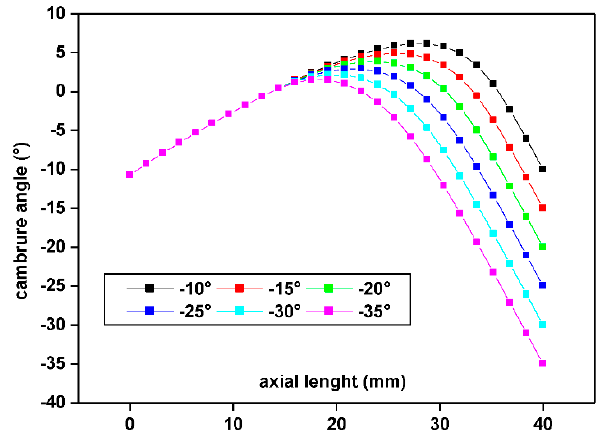
Figure 14. The new camber lines blade’s view.